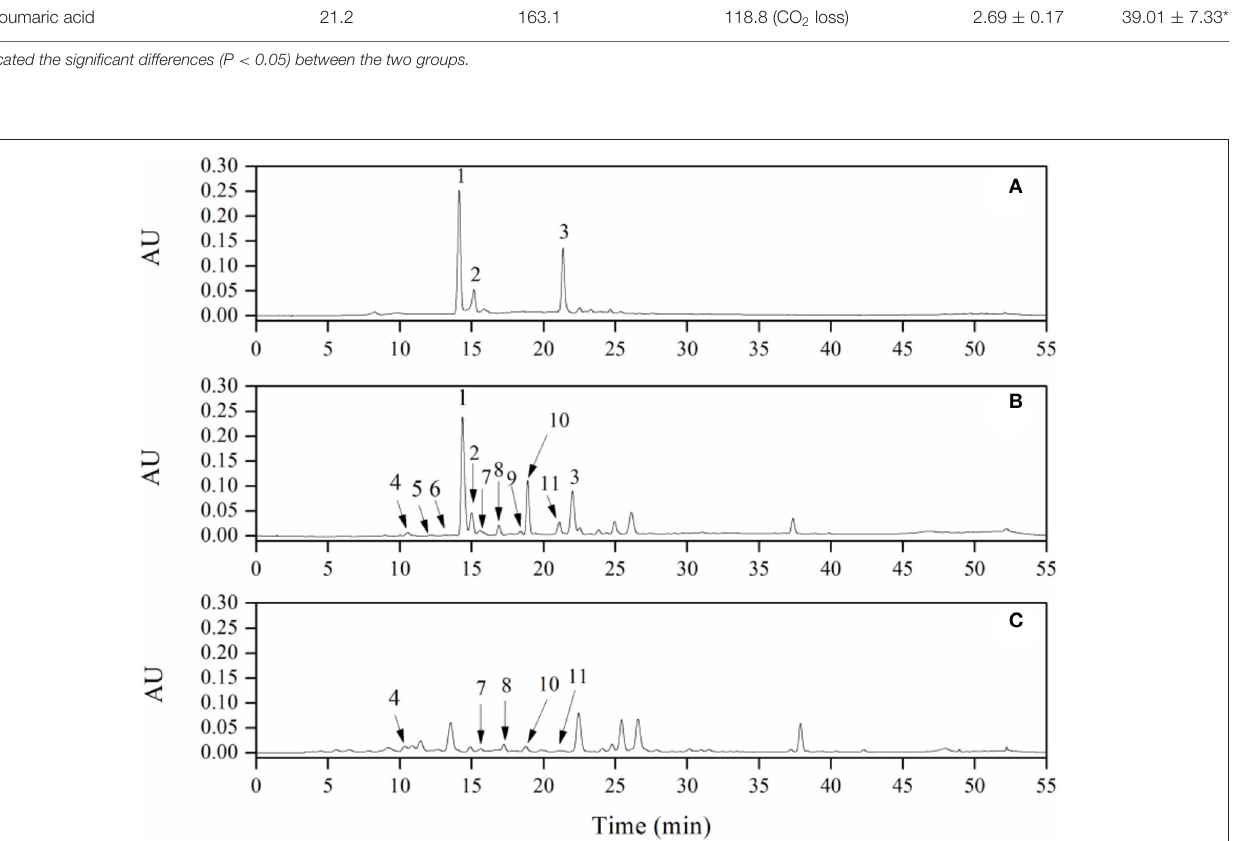
TABLE 1 | Metabolites excreted in urine within 24h fed with litchi pericarp (LPPC). Compounds Retention time (min) Parent ion (m/z) Product ion (m/z) Urinary excretion Procyanidin (% to oral dose) (-)-Epicatechin